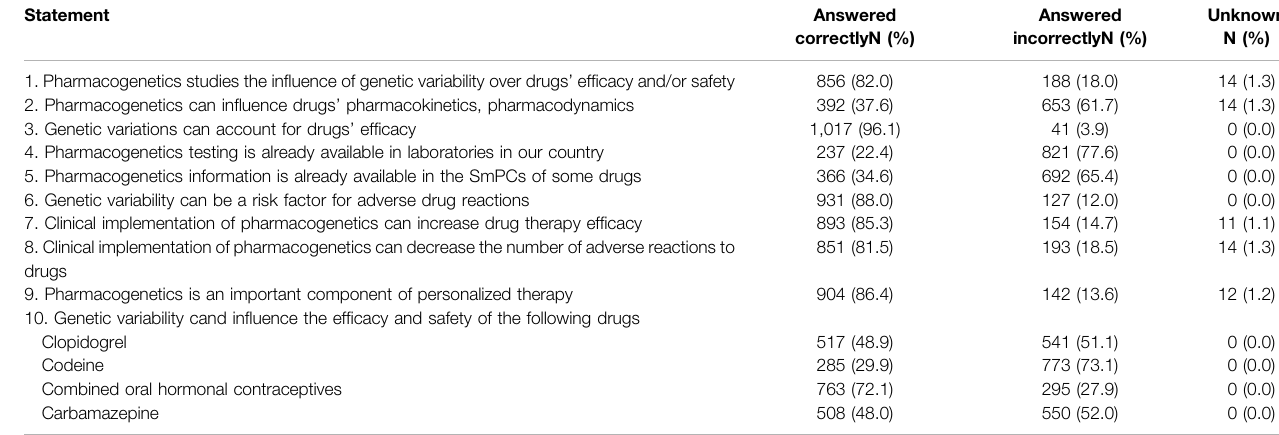
TABLE 2 | Pharmacists ’ knowledge of